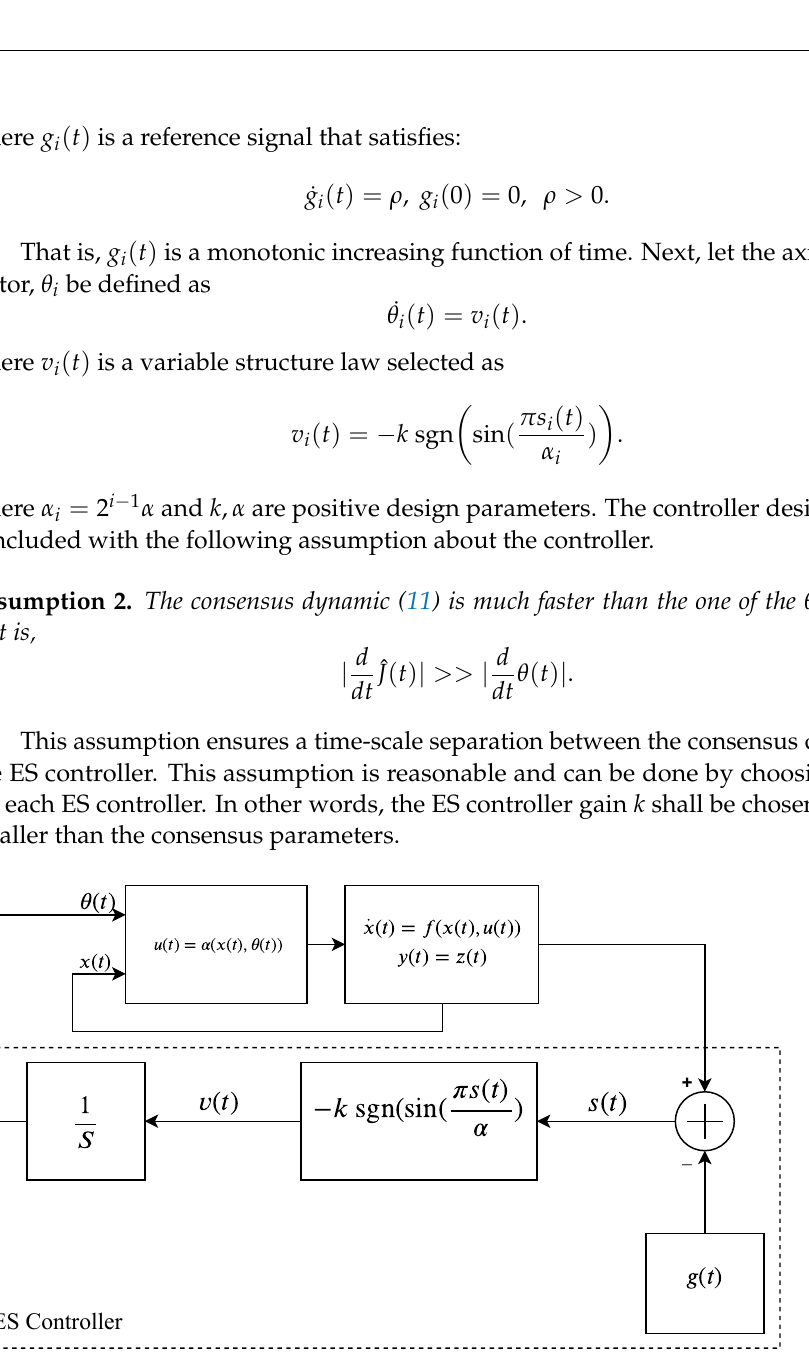
Figure 3. Block diagram for sliding-mode-based extremum-seeking control for a general nonlinear